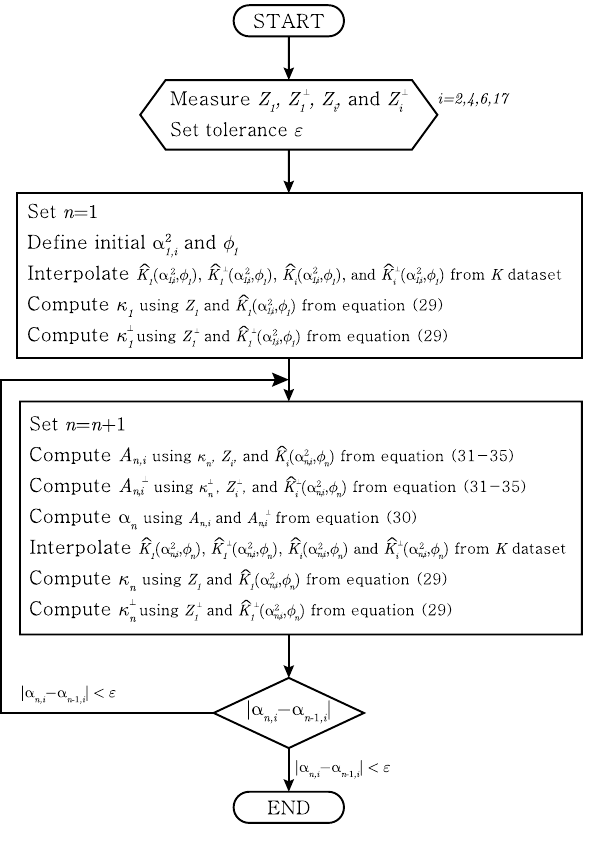
Figure 7. Iteration scheme of the method